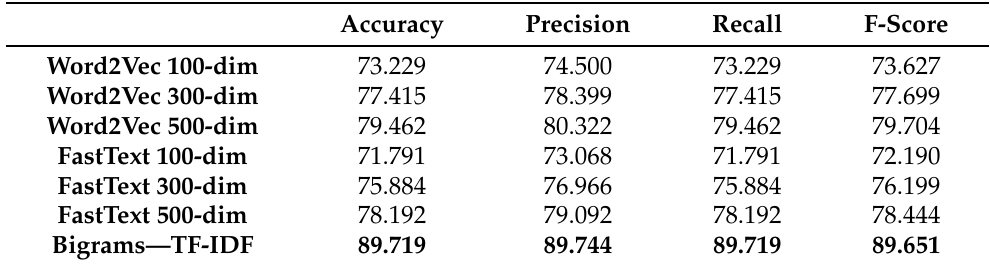
Table 5. Logistic Regression Results in the Ride-Hailing